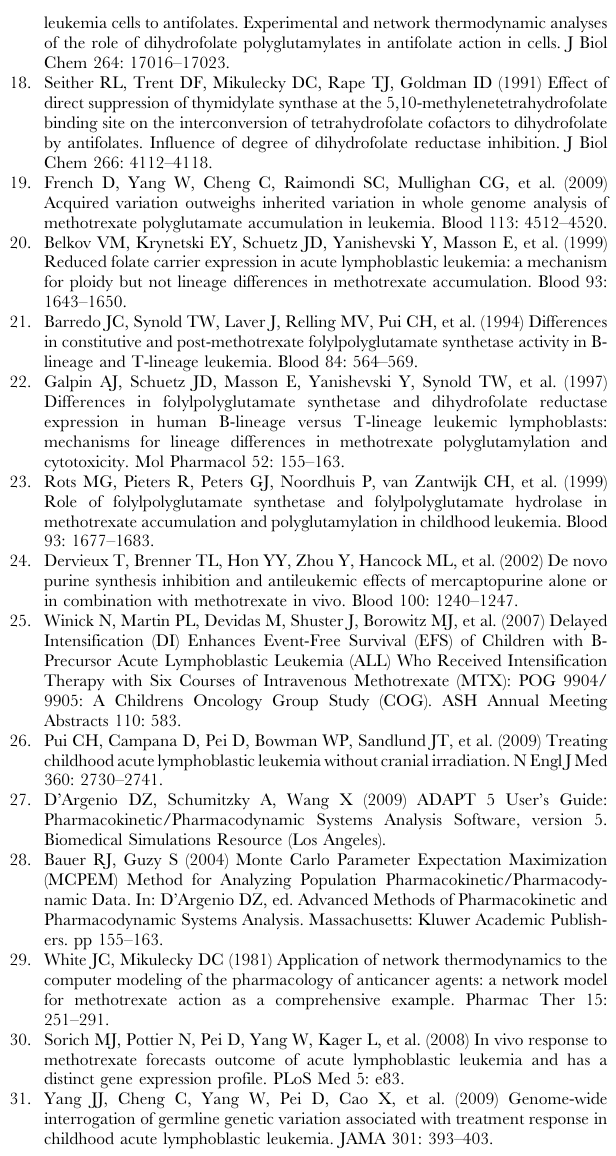
Figure S2 Sensitivity analysis plots. Figure S3 Folate pathway model. Table S1 Summary statistics of all patients randomized in Total XV subdivided by those included in the current study. Table S2 Population mean parameters for all the patients (n =194) estimated by Monte Carlo Parameter Expectation Maximization (MCPEM) with importance sampling population estimation algorithm in ADAPT 5. RSE: relative standard error;